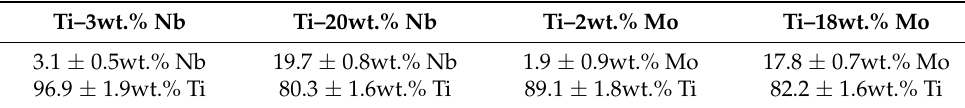
Figure 1. Ti–Nb ( a ) and Mo–Ti ( b ) phase diagrams constructed based on the data [14,32]. Vertical lines and blue circles indicate the phase compositions and the annealing temperatures of the examined alloys, respectively. Table 1. The chemical composition of the investigated